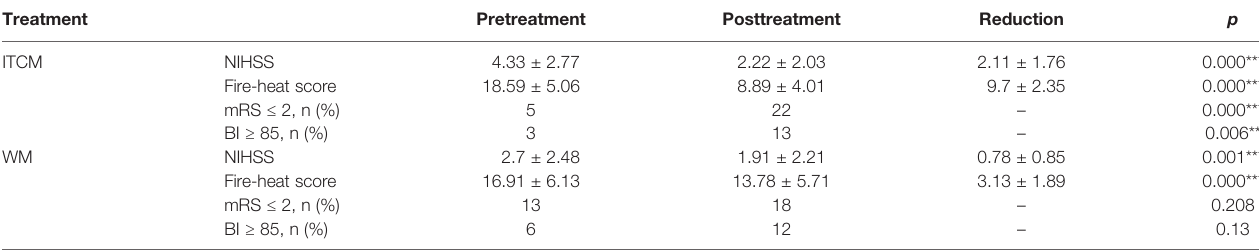
TABLE 2 | Comparison in ITCM group for pretreatment and posttreatment.